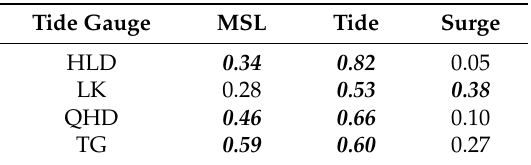
Table 3. Correlations between the extreme sea level and components.